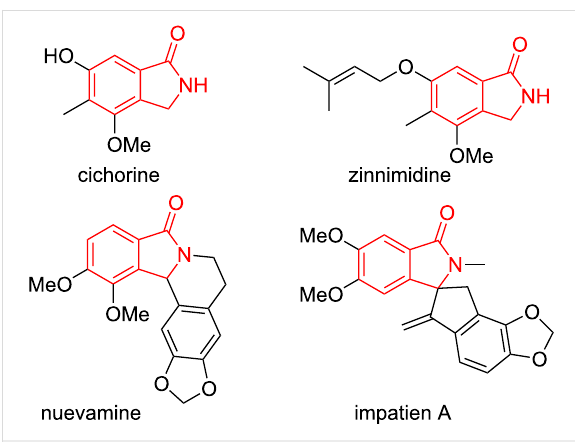
Figure 2: Alkaloids containing an isoindolinone moiety.